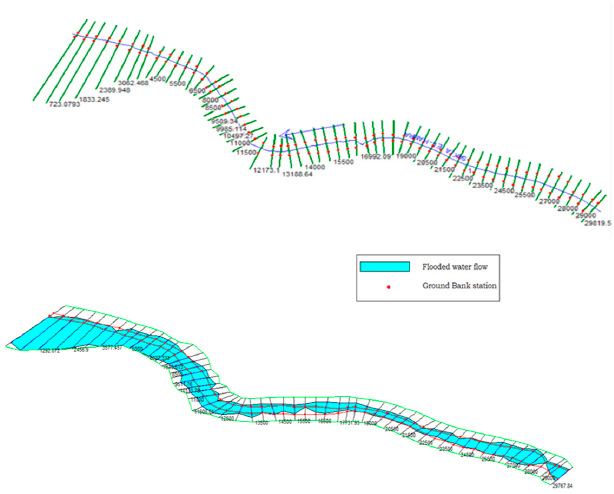
Figure 10. Adjustments of the static laws on the annual maximum daily flows.